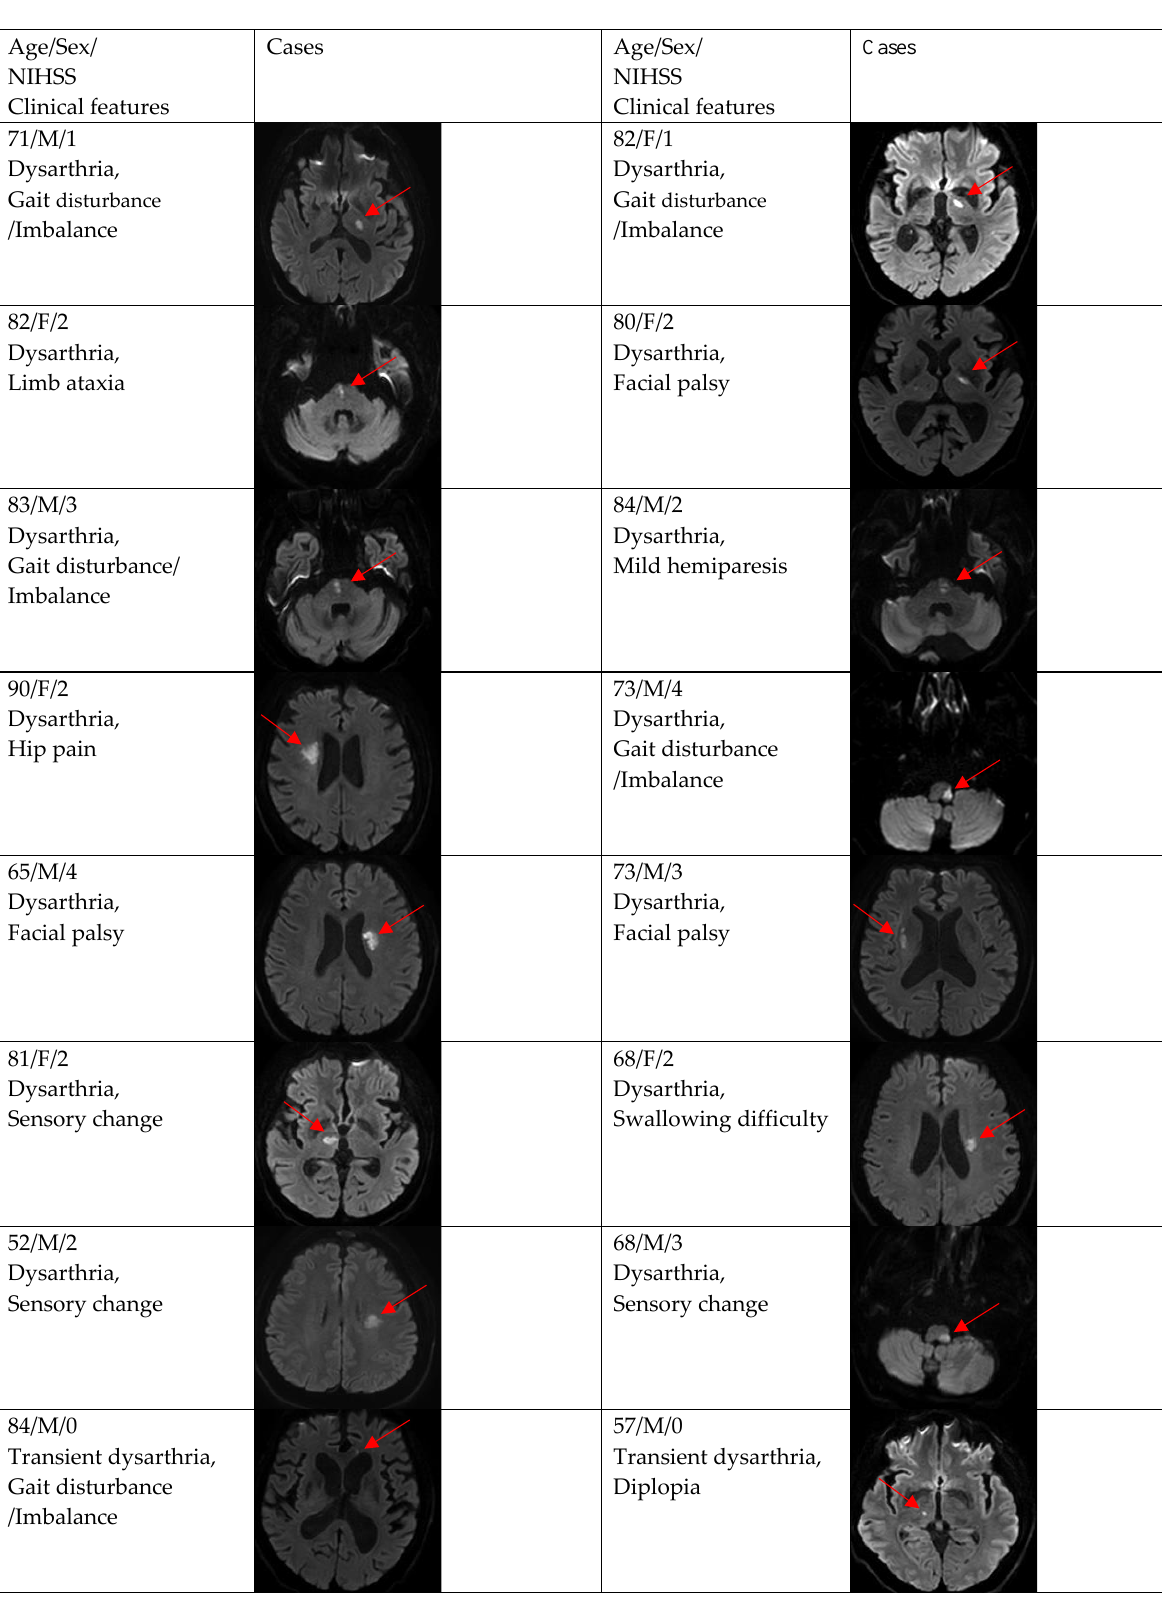
Figure 3. Clinical characteristics and neuroimaging findings of patients with ischemic stroke or TIA presenting with prominent dysarthria and small and single